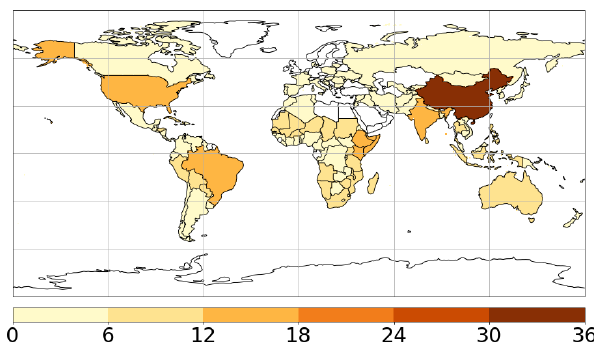
Figure 7. The number of drought events based on